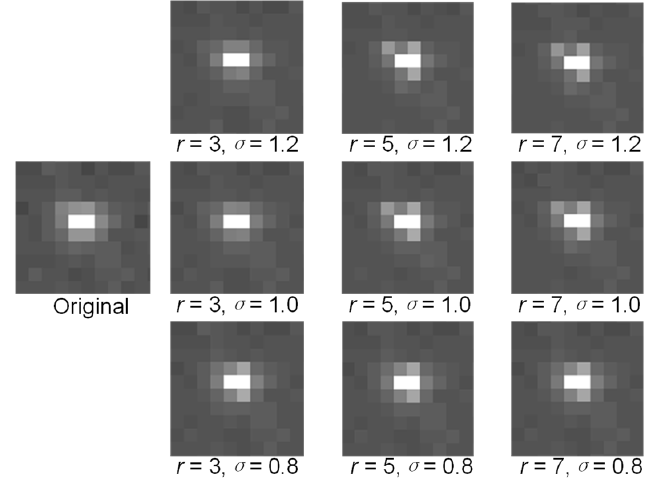
Figure 8. Results for different values of r and σ .